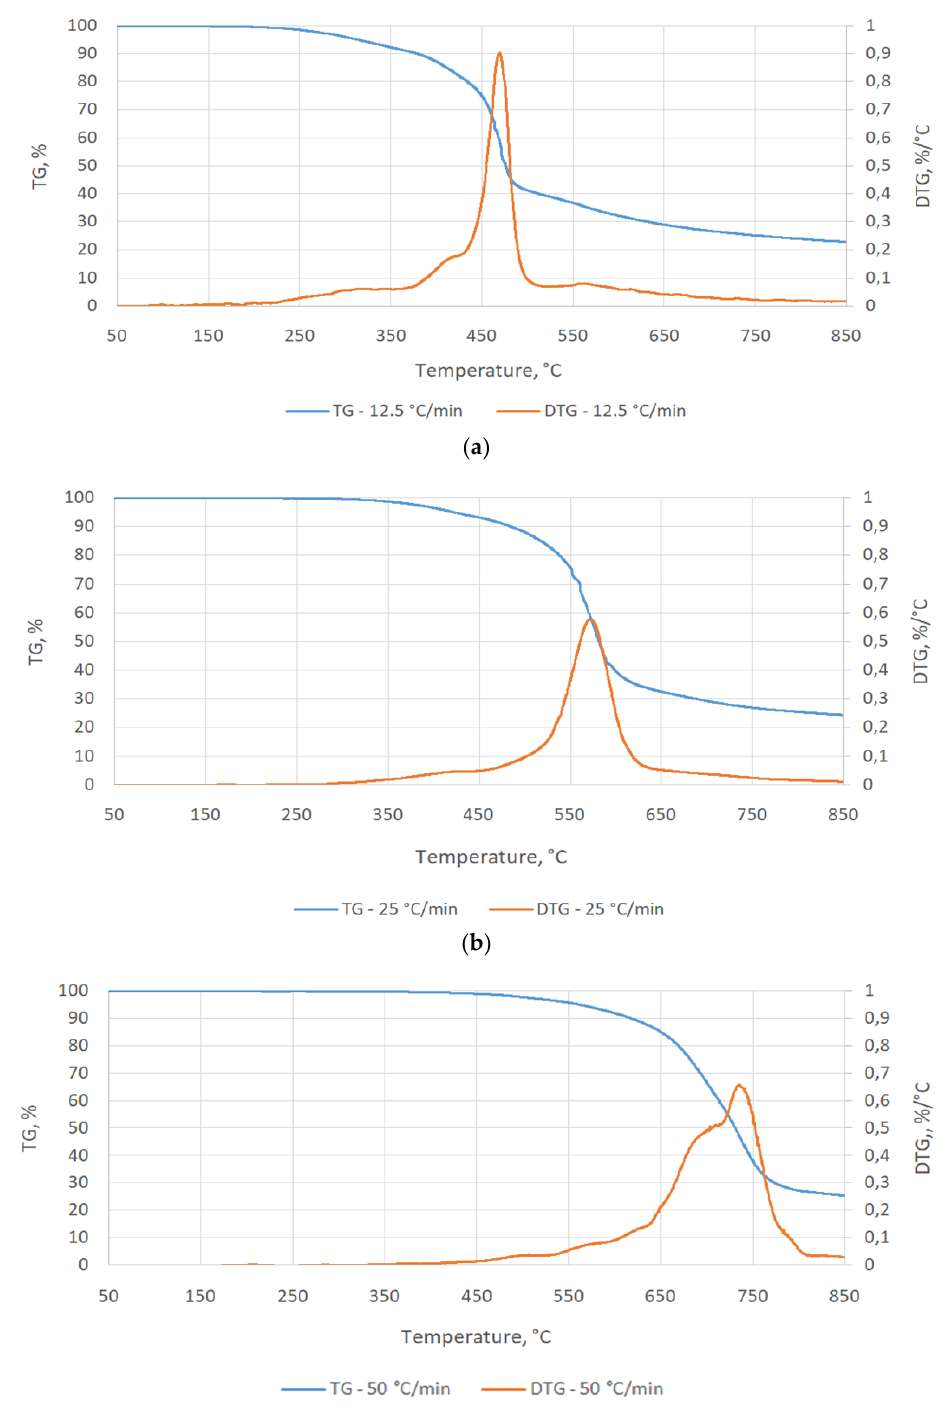
Figure 3. Results of TG/DTG analysis of barley malt for the heating rate: ( a ) 12.5 °C/min, ( b ) 25 °C/min, ( c ) 50 °C/min. ( b ) 25 ◦ C/min, ( c ) 50 ◦